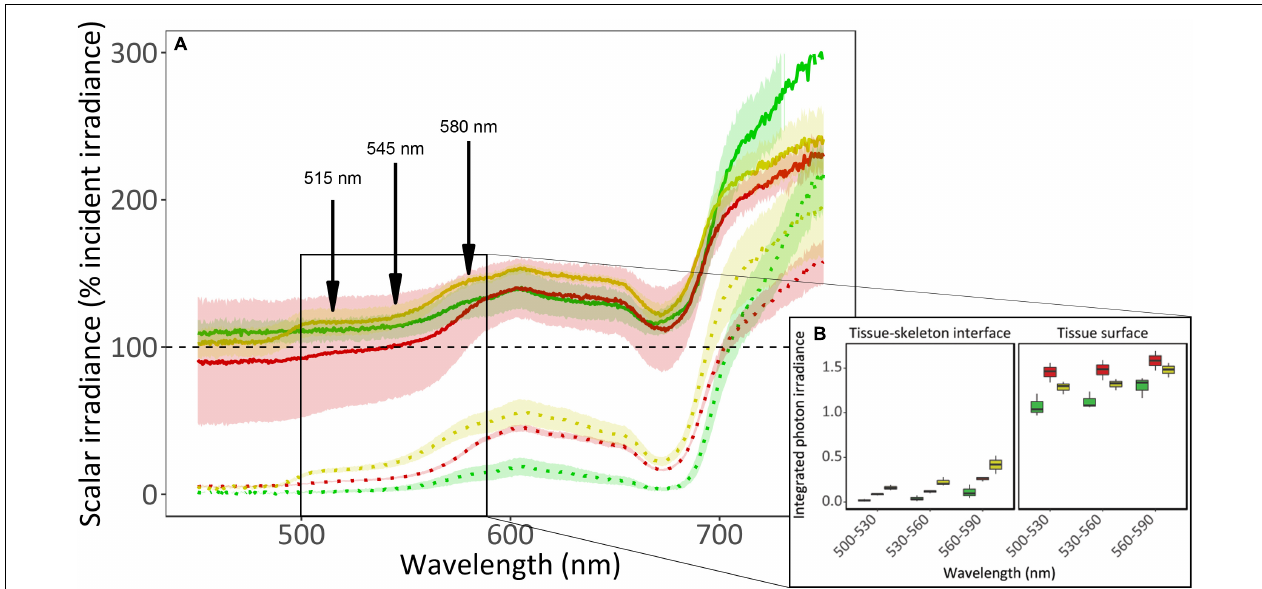
FIGURE 2 | In vivo spectral scalar irradiance of three fluorescence morphs of the mesophotic coral Goniopora minor . (A) Scalar irradiance ( E 0 ) was measured at the coral tissue surface (solid lines) and at the tissue-skeleton interface (dotted lines) of red (colored red), green (colored green), and yellow (colored yellow) fluorescence morphs of the mesophotic coral G. minor . Dashed black line indicates 100% of the incident irradiance ( E d ). Colored lines represent the mean relative scalar irradiance ( n = 3) of each morph and confidence intervals are represented by transparent corresponding areas. Fluorescence emission peaks are indicated by arrows. The solid box indicates an area of interest corresponding to (B) the integrated photon irradiance ( n = 3) for specific wave bands (500–530 nm, 530–560 nm, and 560–590 nm) for the three fluorescence morphs. Boxes represent the upper and lower quartile, center lines represent medians, and whiskers extend to data measurements that are less than 1.5 ∗ IQR (interquartile range) away from first/third quartile.